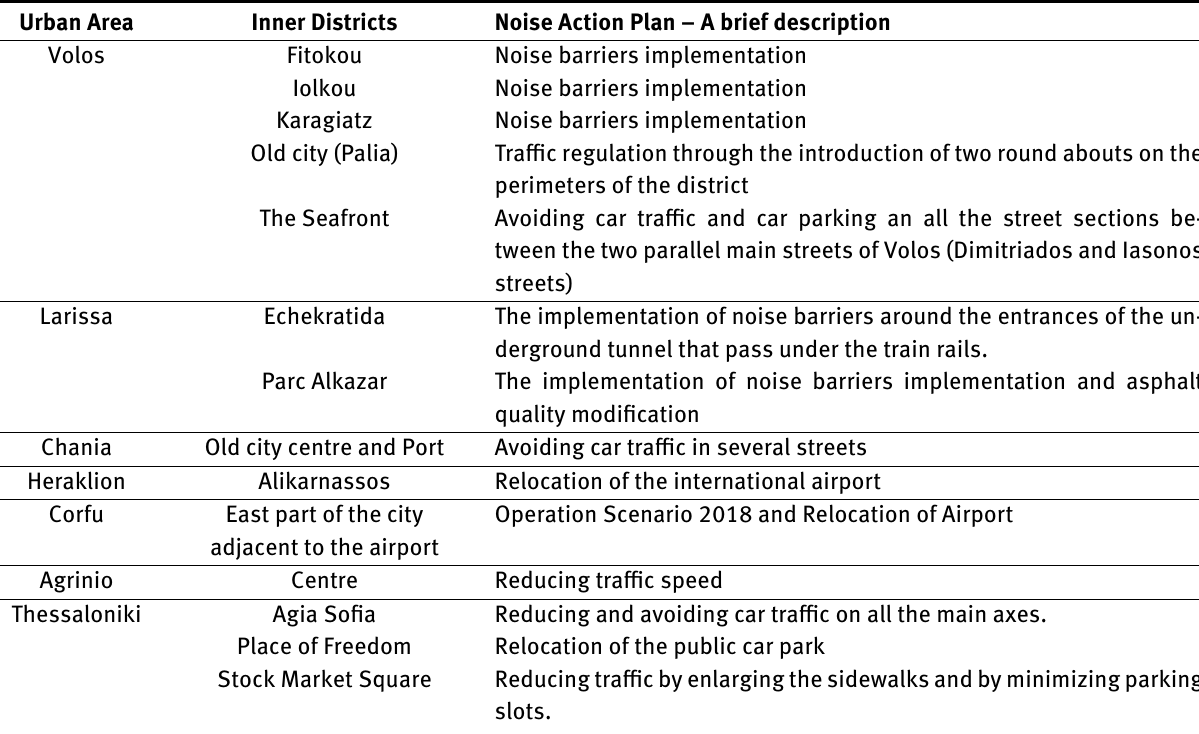
Table 4: Noise Action Plan (N.A.P.) Brief Description by selected district within the 7 U.A. in Greece. Urban Area